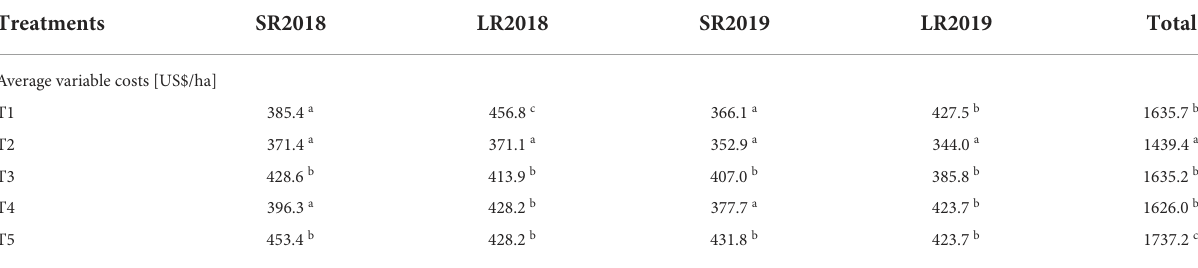
TABLE 7 Comparison of total variable costs incurred during implementation of treatments in the four crop-growing seasons during 2018 and 2019. Treatments